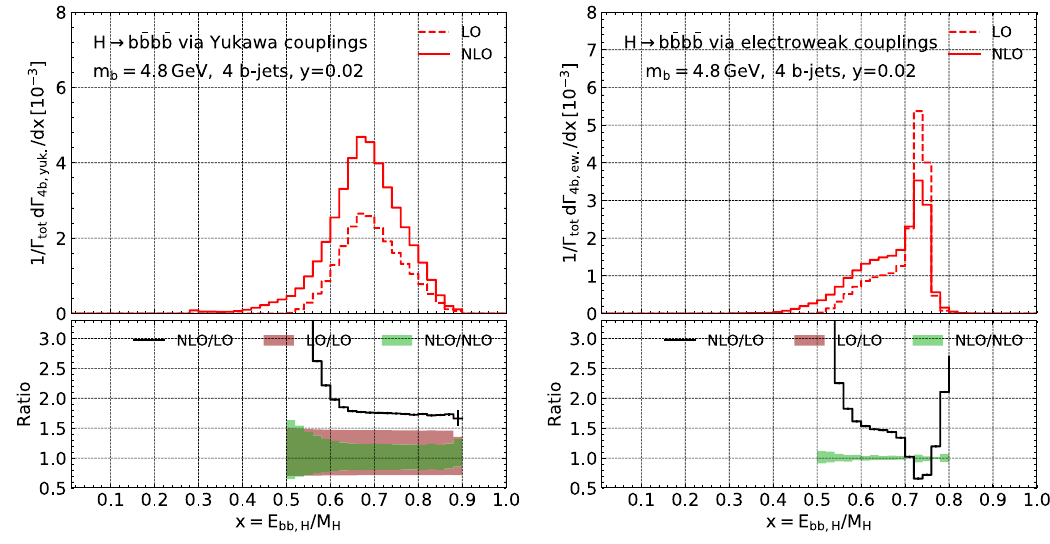
Figure 15 . Similar to figure 7 for distribution as a function of the highest energy of all b -jet pairs.